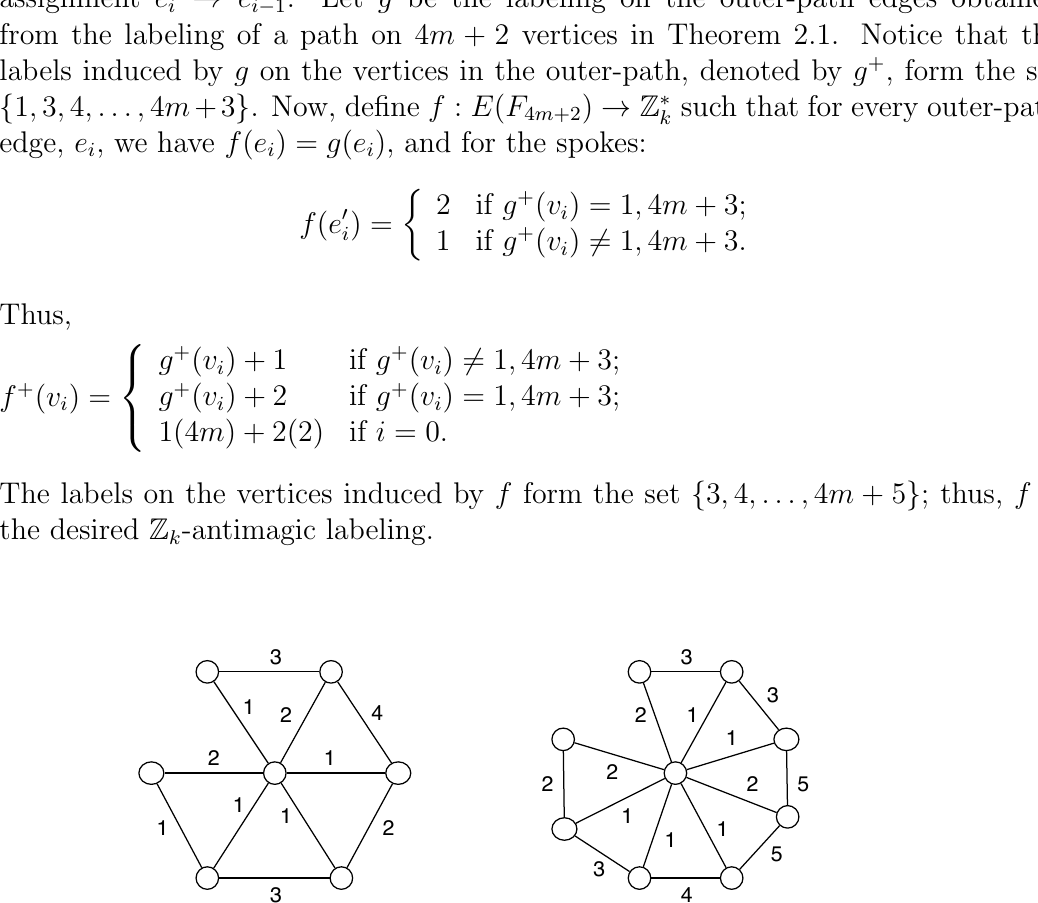
for k (cid:21) 7, and F 6